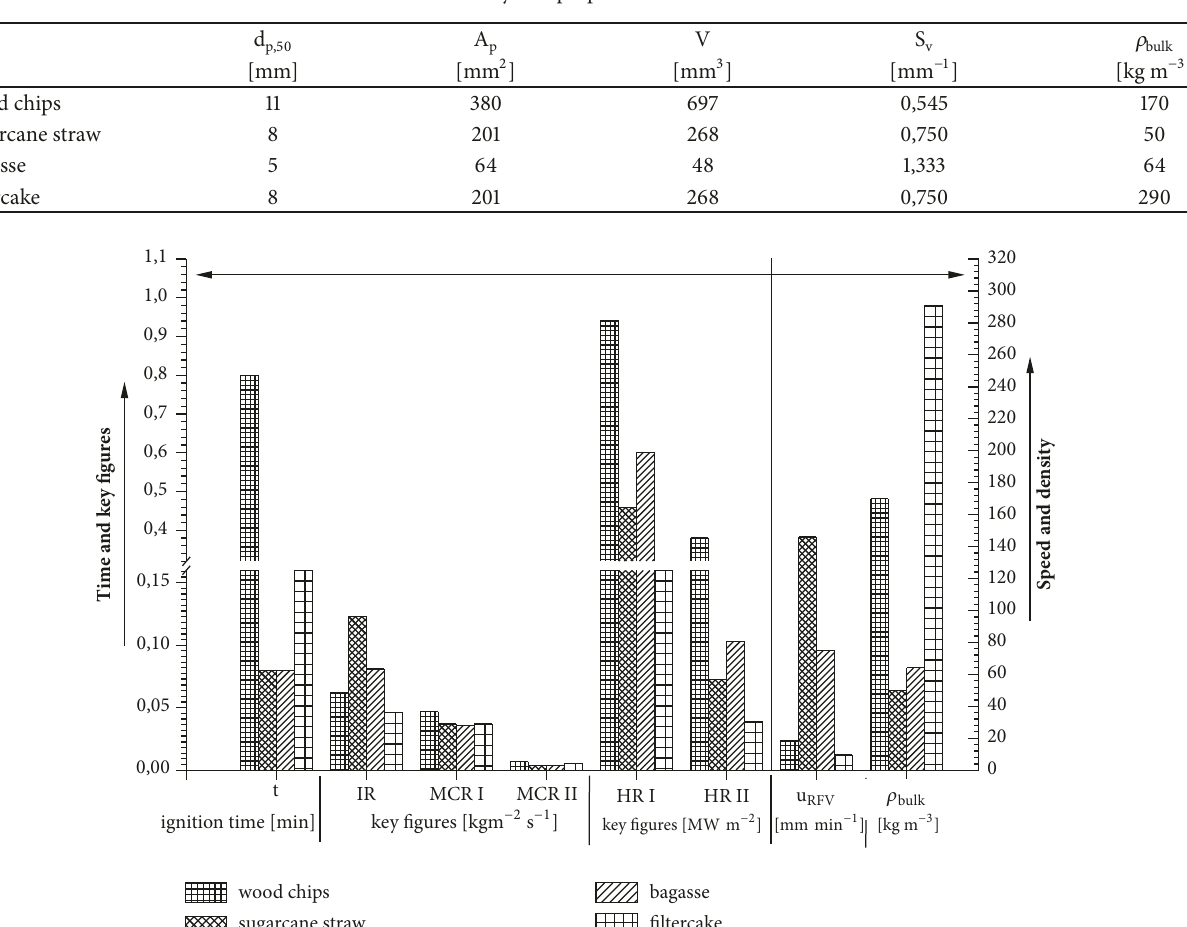
Figure 7: Comparison of characteristic figures as determined from preliminary